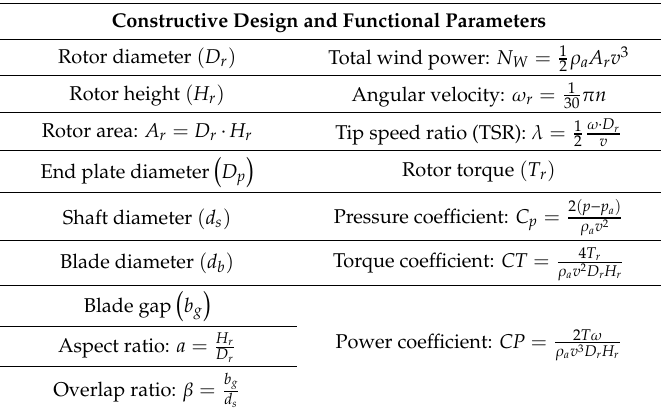
Table 1. Basic constructive and functional parameters of the Savonius turbine